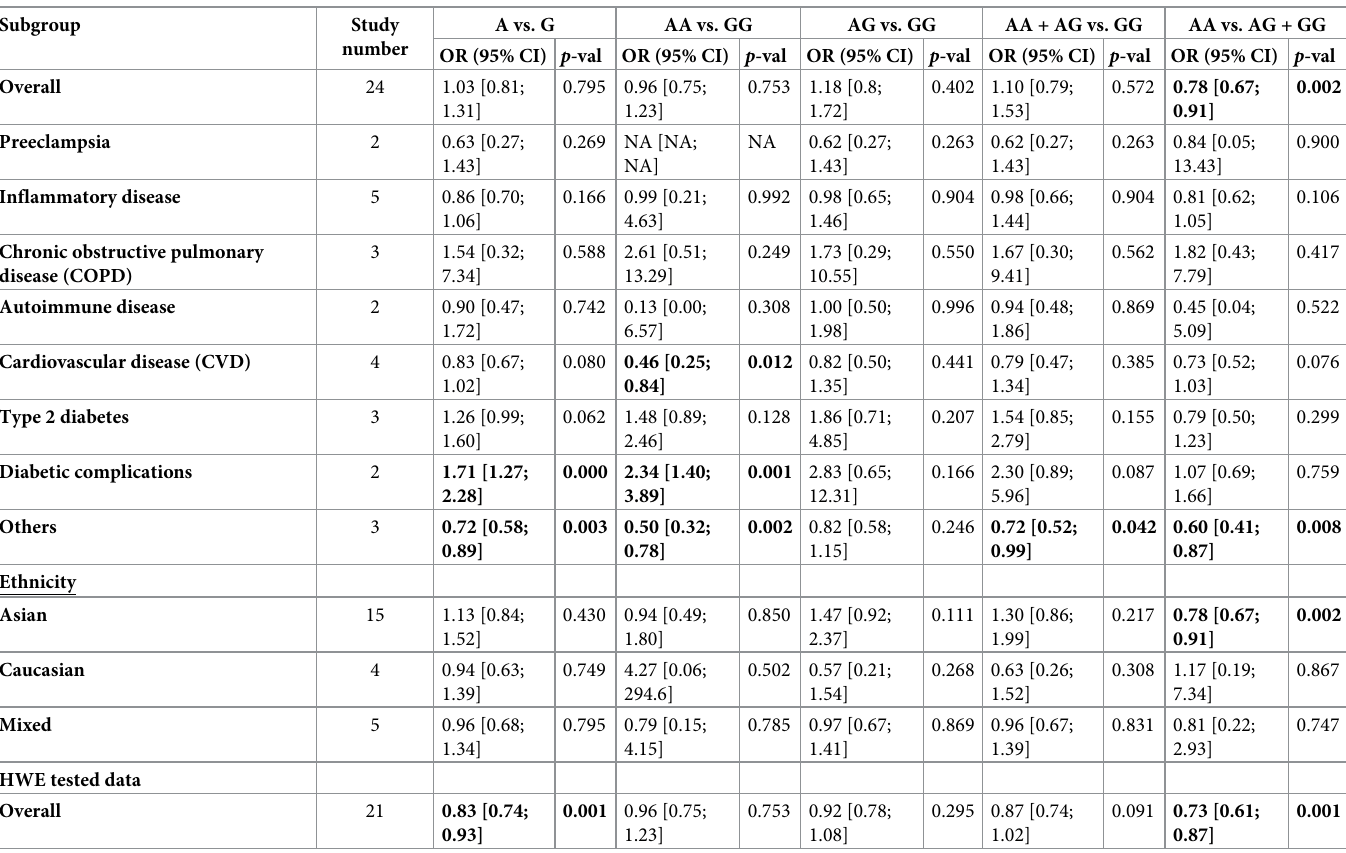
Table 3. Summary results of ORs and 95% CI of HIF1A rs11549467 G/A polymorphism association with diseases.